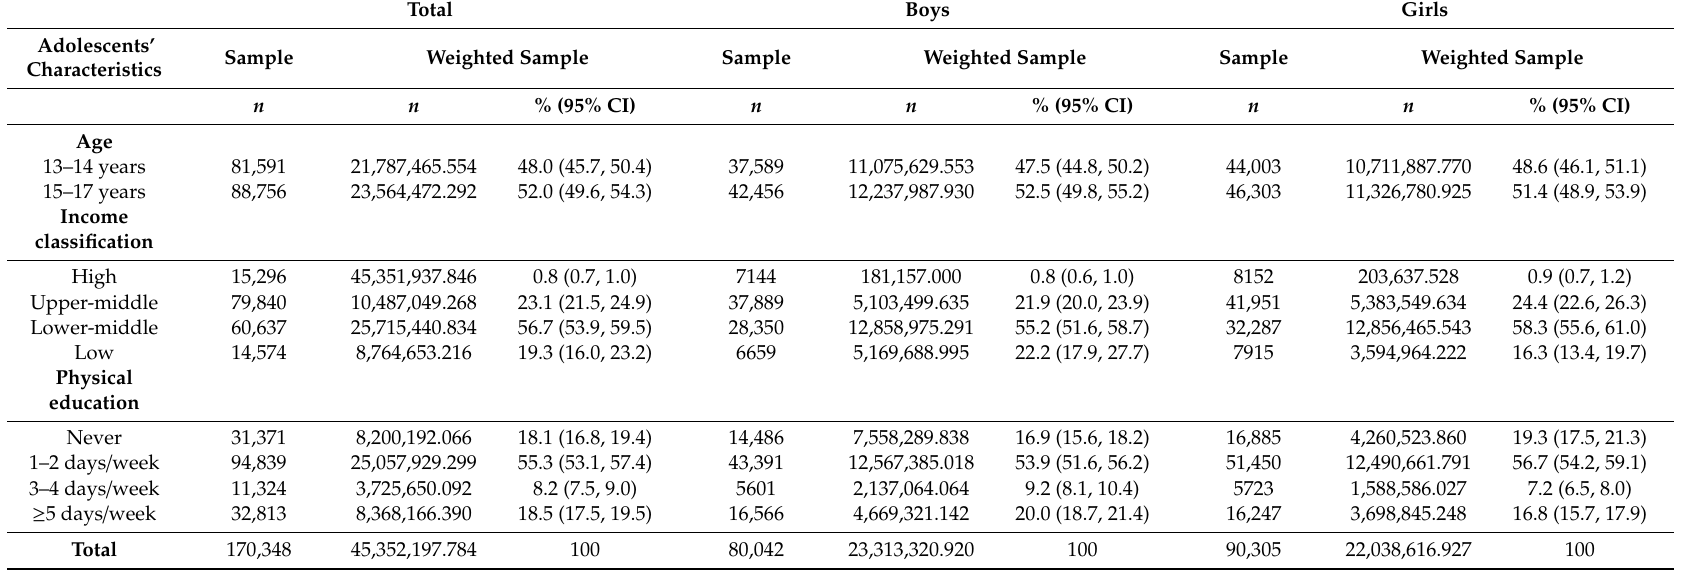
Table 1. Adolescents’ characteristics stratified by